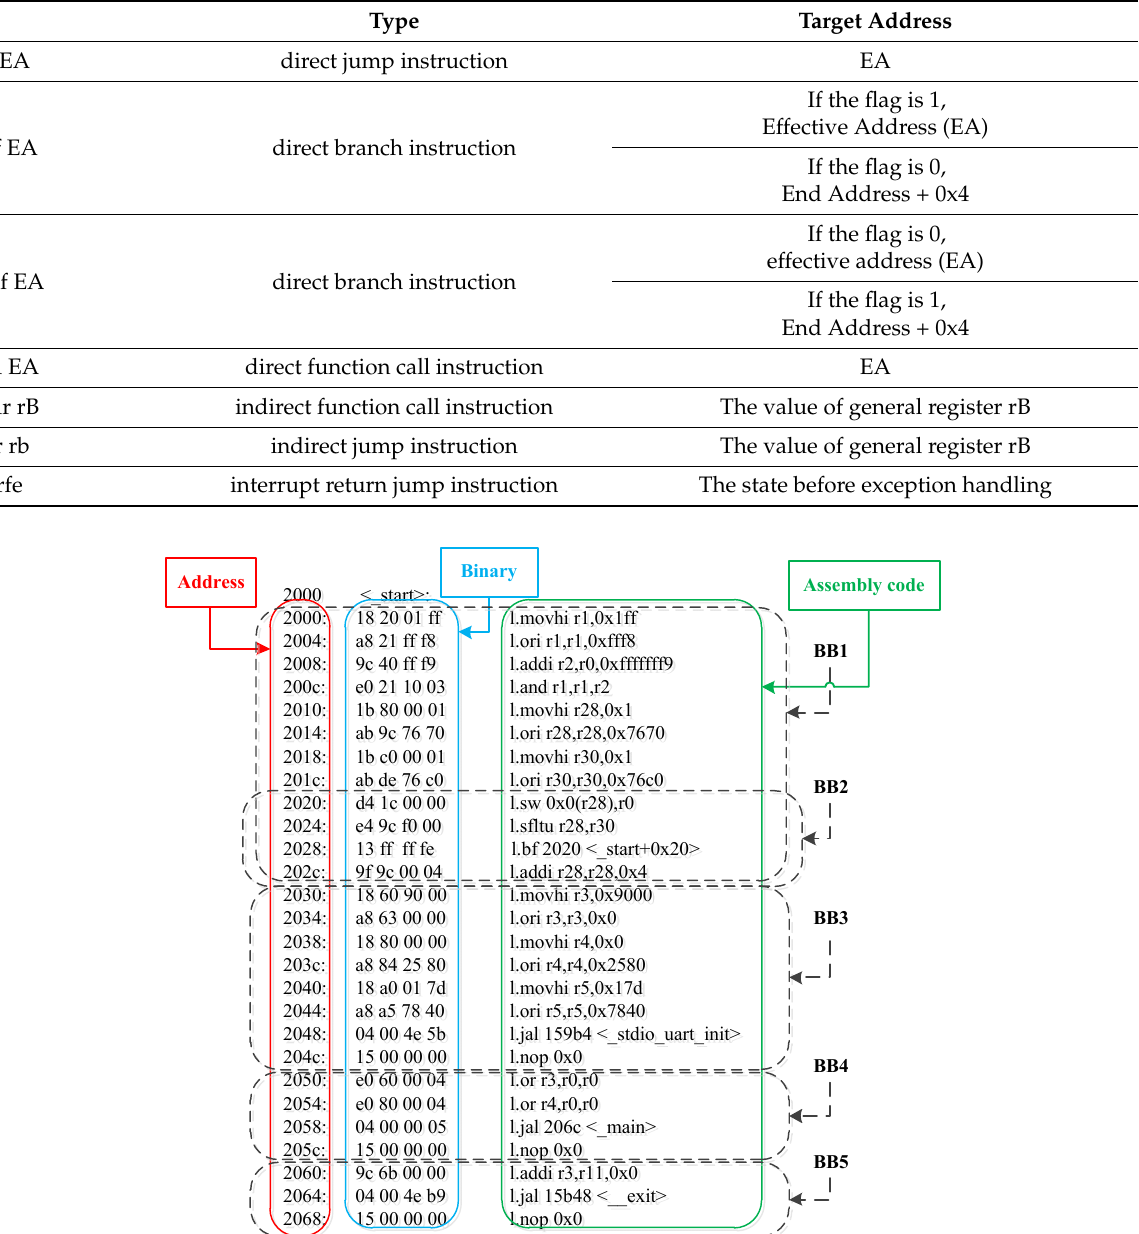
Figure 1. The example of BB extraction in OR1200 ISA.